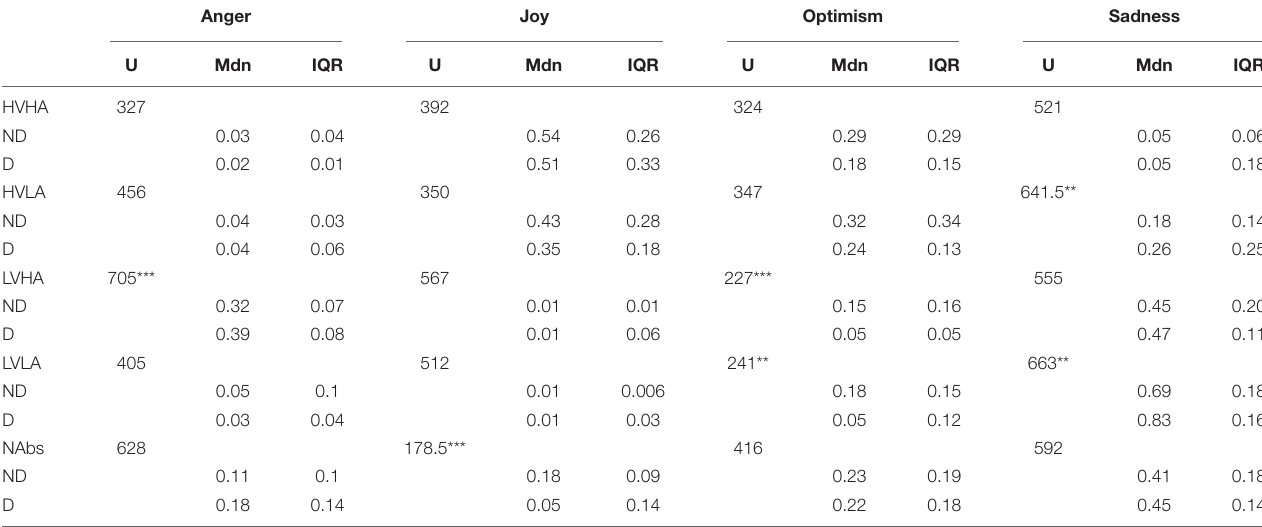
TABLE 4 | Emotion ratings calculated by TweetEval for stimuli